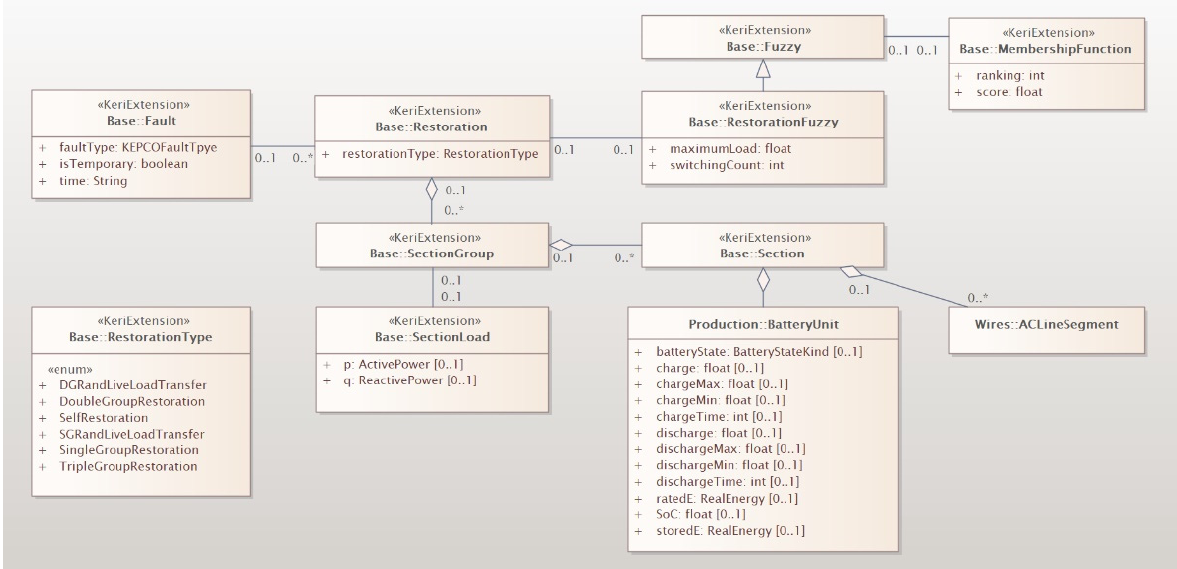
Figure 16. A UML diagram of the service restoration plan using the ESS.